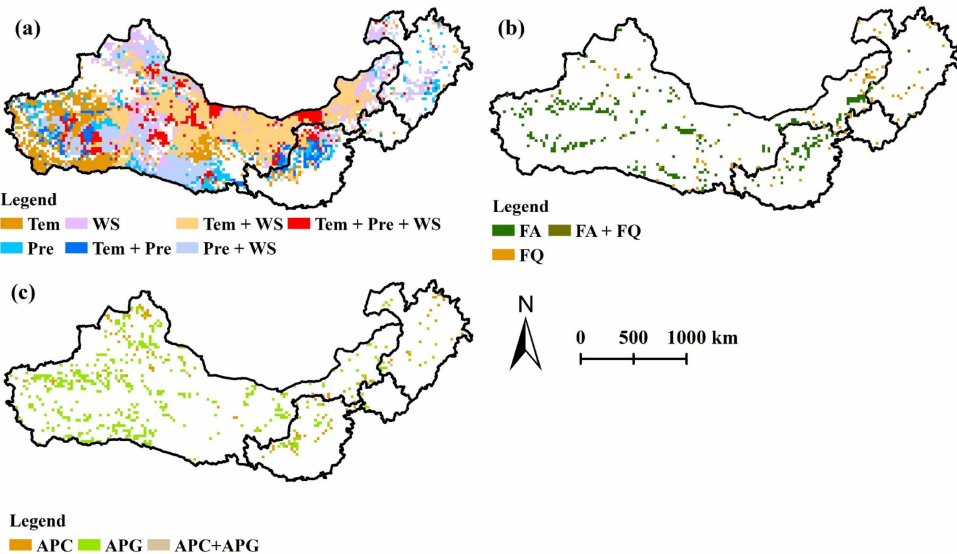
Figure 12. Multiple linear regression coefficients of driving factors between wind erosion and ( a ) climate changes, ( b ) ecological programs, and ( c ) human interference. [Temperature (Tem), precipitation (Pre), wind speed (WS), area proportion and quality of forest and shrubland (FA and FQ), area proportion of cropland in a 1km × 1km grid (APC), and area proportion of grassland in a 1km × 1km grid